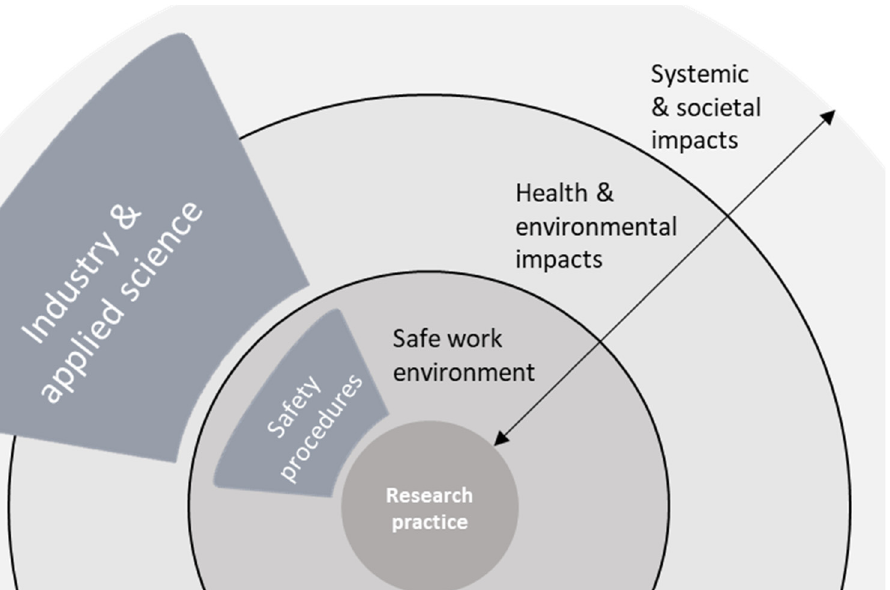
Figure 5. Attention for work safety is covered by adherence to safety procedures. Attention to more distant impacts is or should be covered by industry or applied science (the arrow depicts types of safety issues and distance from research practice).